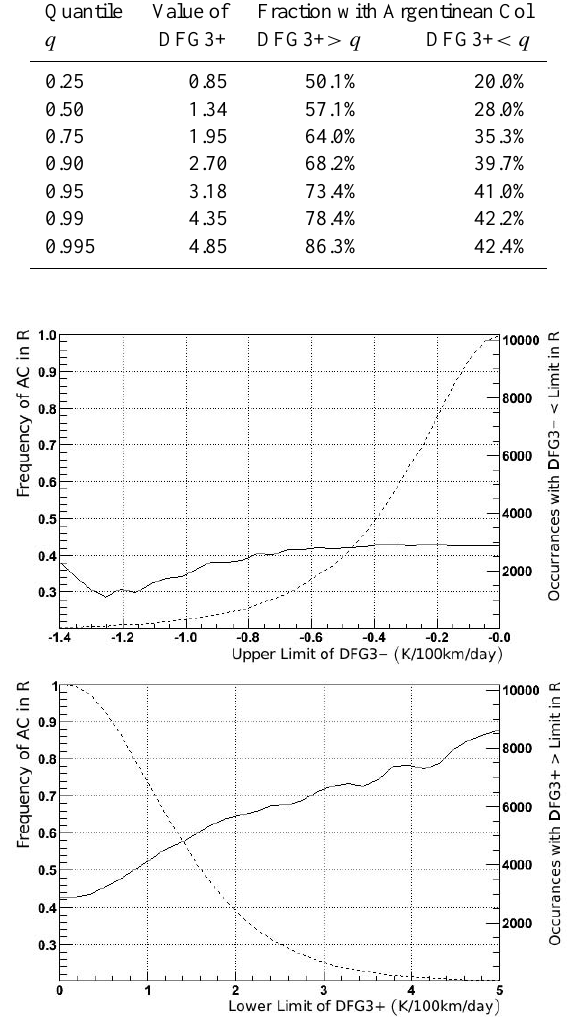
Fig. 7. Right: horizontal axis represents limiting values of DFG3+. The dashed line curve shows the number of events with DFG3+ greater than limit, while the continuous line curve shows the frac- tion of these events in which AC was found in R. Left: same as the right panel but for DFG3 − lower than limit.